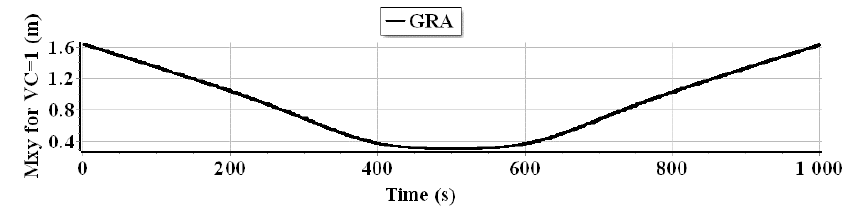
Figure 25. Graph of mean error M xy of GRA-estimated position coordinates during 100 SV crossings, relative to triangle marks as a function of